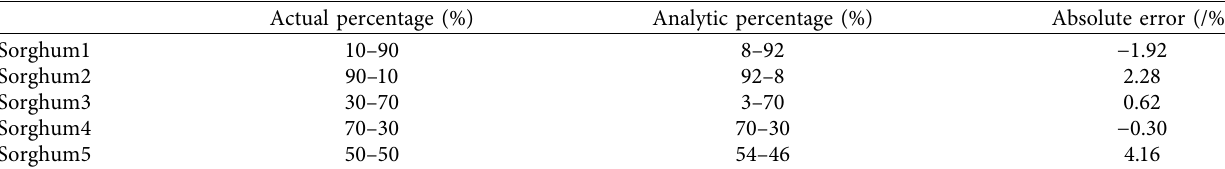
Table 8: Analytic percentage, actual percentage, and the absolute error between them of sorghum